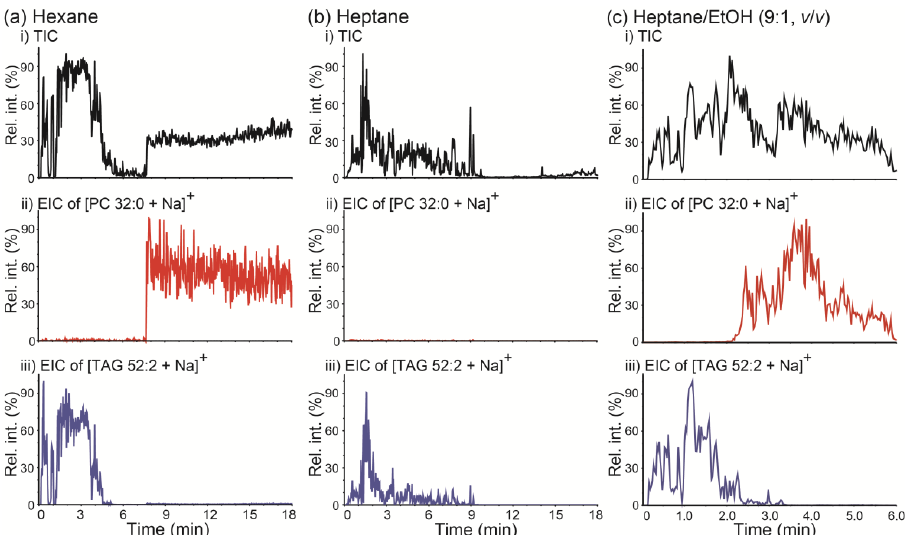
Figure 5. ( a – c ) (i) Total ion chronograms (TICs) of paper spray ionization mass spectrometry (PSI MS) analysis of a mixture of PC 32:0 and TAG 52:2 and extracted ion chronograms (EICs) for (ii) the [PC 32:0 + Na] + ion at m/z 756.5 and (iii) the [TAG 52:2 + Na] + ion at m/z 881.8. PSI MS was performed by wicking mode with ( a ) hexane, ( b ) heptane, and ( c ) heptane/ethanol (EtOH) (9:1, v/v ) as spraying solvents. PC 32:0: 1,2-dipalmitoyl- rac -glycero-3-phosphocholine; TAG 52:2: 1,3- dioleyl-2-palmitoyl-glycerol.